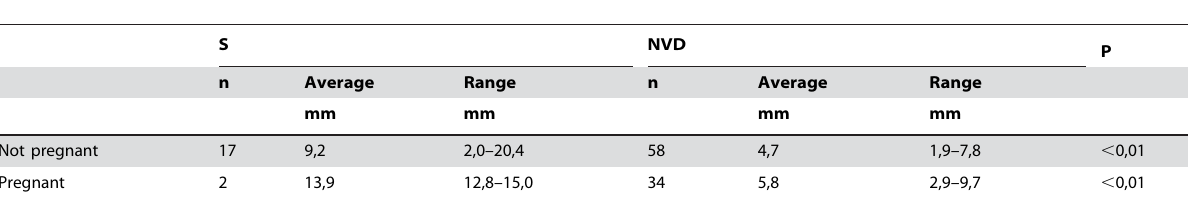
Table 3. The width of symphysis pubis after S and after NVD.